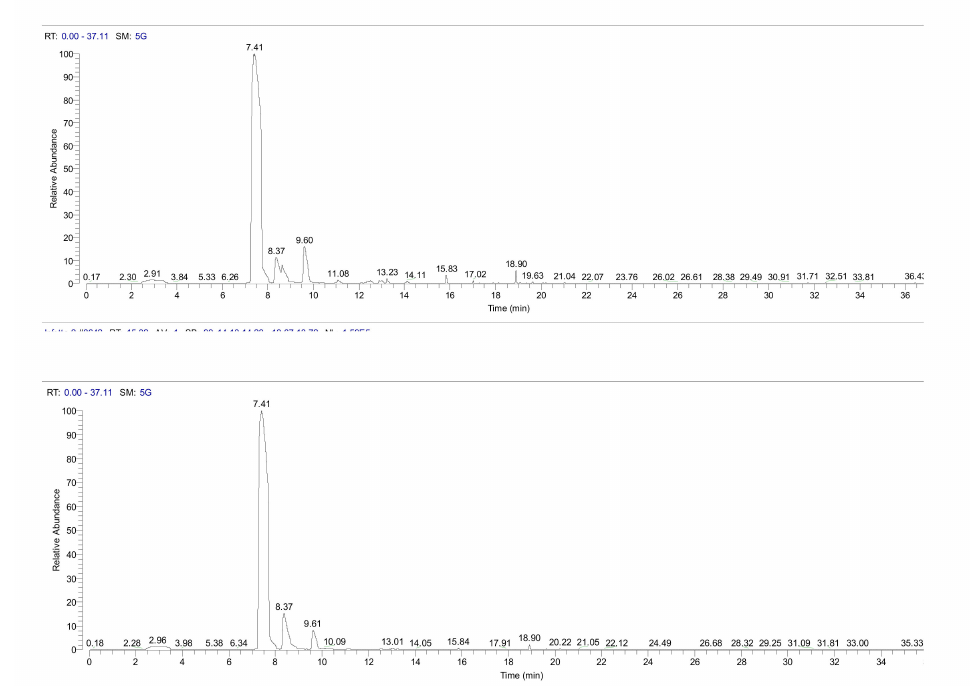
Figure 2. A typical headspace-GC / MS chromatogram obtained from Calabrian pine needles collected at Canolo Nuova. Upper panel, plant infested by the pine processionary moth; lower panel, not infested (control)